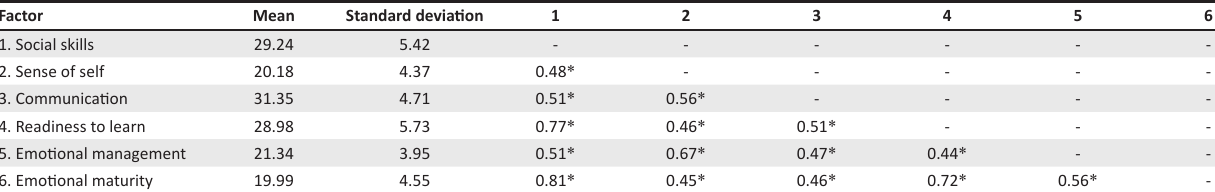
TABLE 3: Means, standard deviations and correlations between factors. Factor Mean Standard